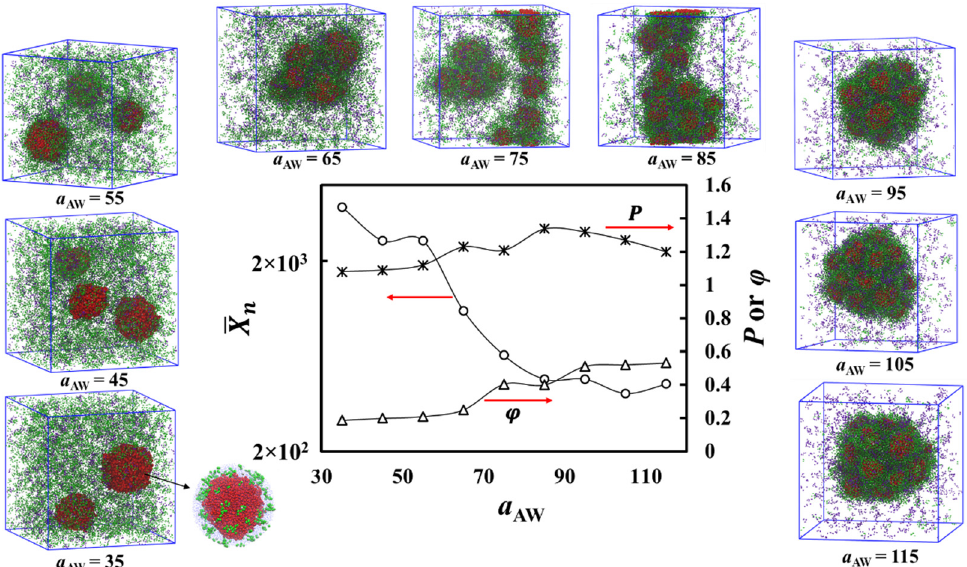
Figure 4. Simulation snapshots and analysis of the aggregate structural changes when a AW is varied in the system containing A 19 (4%), A 1 - b -S 6 (13%), and S 6 (3%). Solvent beads are omitted for clarity. The color scheme is the same as that of Figure 1. The data graphs show mean aggregation number X n , polydispersity index (P) of the solvophobic cores, and the order parameter ( ϕ ) of the overall aggregate versus the more solvophobic polymer–solvent interaction parameter a AW . Error bars are smaller than the symbol size. The scatter in the data is due to finite size effects in the simulations.